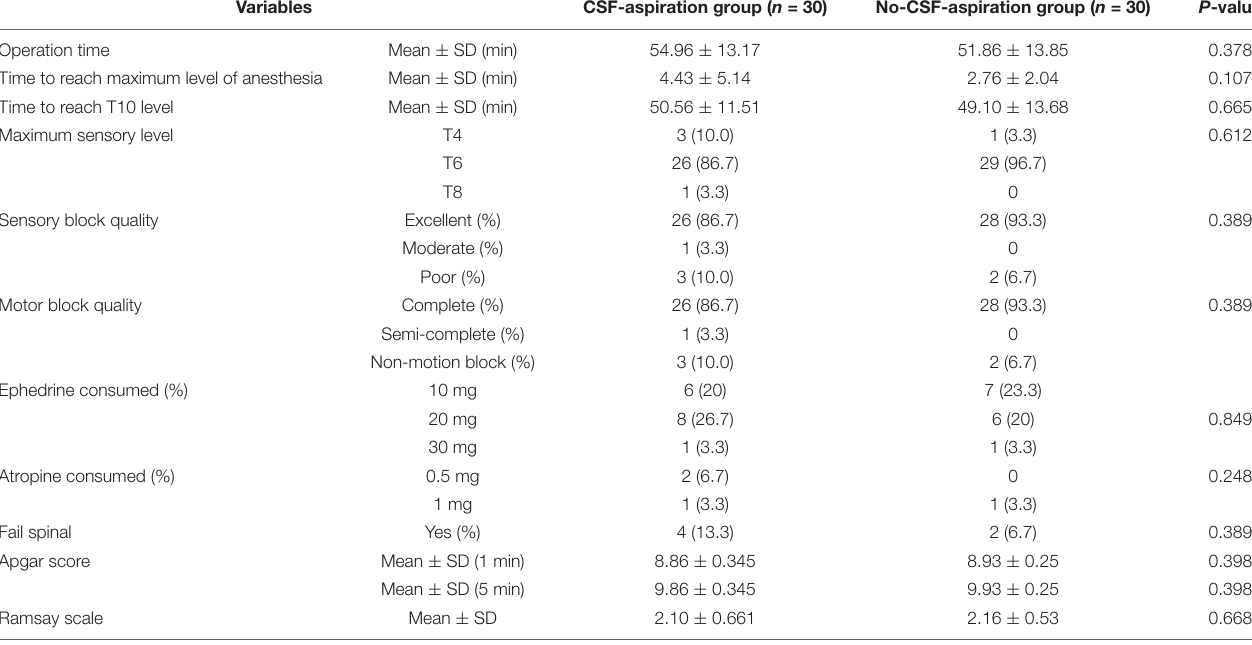
TABLE 2 | Comparison of spinal anesthesia characteristics and outcomes in two groups of study. Variables CSF-aspiration group ( n = 30)